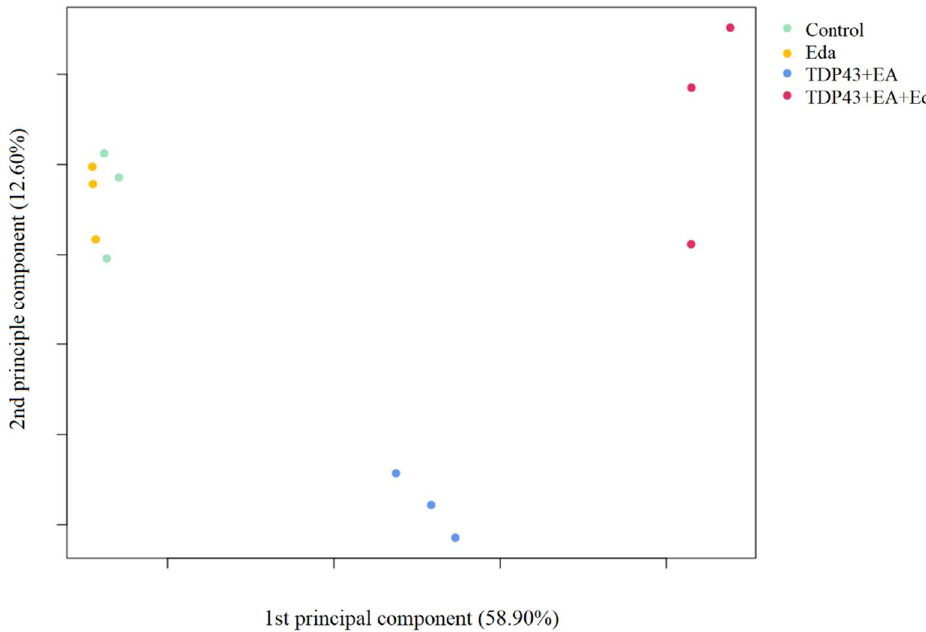
Figure 3. Principal component analysis. Values in parenthesis on the X- and Y-axis titles represent contribution rates. Light green, orange, blue, and red dots represent samples in the Control, Eda (edaravone-treated cells), TDP43 + EA (ethacrynic acid-treated cells expressing TDP-43), and TDP43 + EA + Eda (edaravone- and ethacrynic acid-treated cells expressing TDP-43) groups, respec- tively. Eda—Edaravone; EA—Ethacrynic acid.